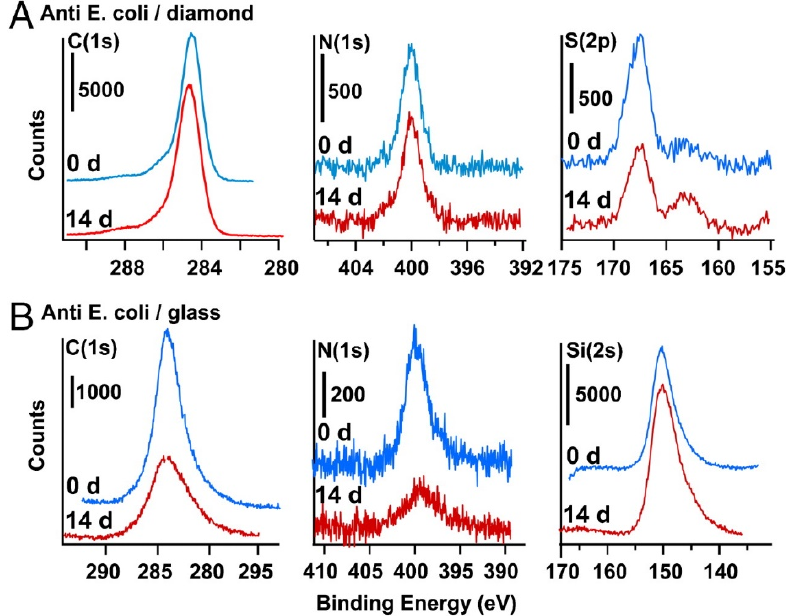
Figure 5. XPS data for surface composition of C, N, S and Si, illustrating stability of E. coli antibody covalently grafted to amine-terminated diamond ( A ) and amine-terminated glass substrates ( B ), before (blue) and after (red) storage for 14 days in PBS buffer at 37 ◦ C. Reprinted with permission from Ref. [80]. Copyright 2011 National Academy of